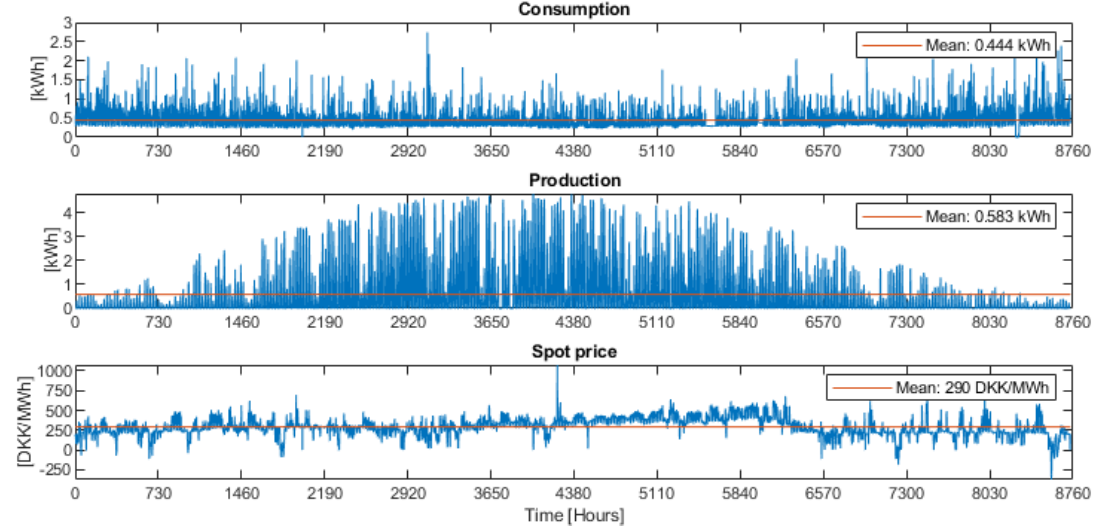
Figure 1. The three time series from the case study, used in the simulations and analysis.